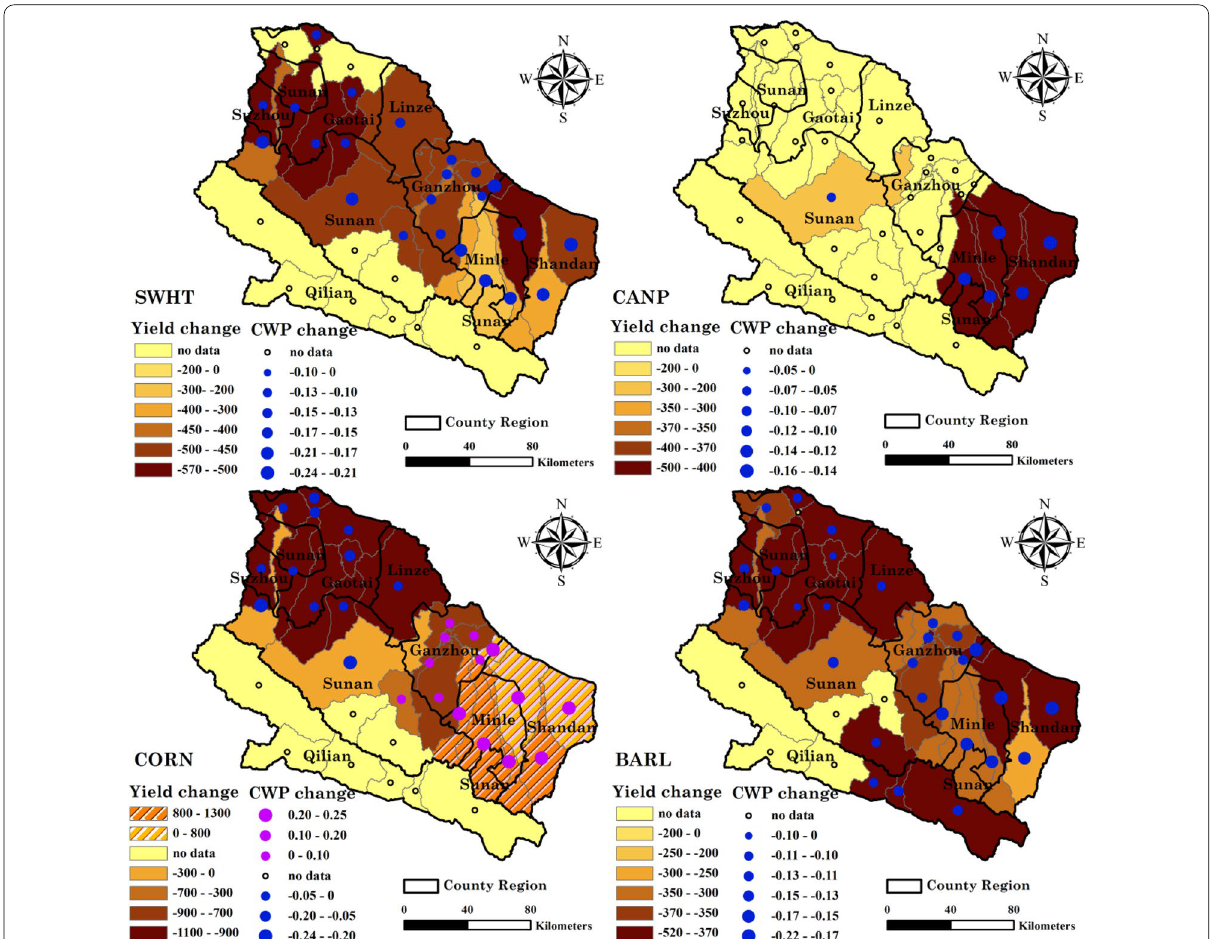
Fig. 8 The change of short-term crop yields and CWP of wheat (SWHT), canola (CANP), corn (CORN), and barley (BARL) relative to the historical baseline period in the climate scenario